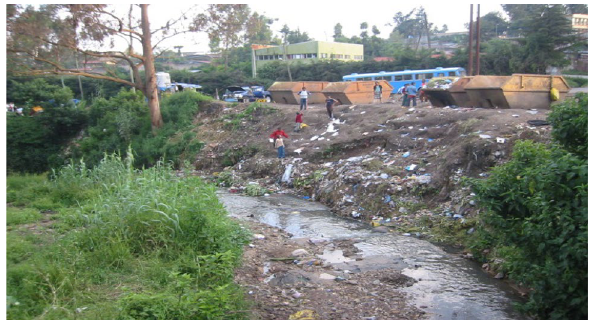
Fig. 11 Wastewater dumping along riversides by the road.